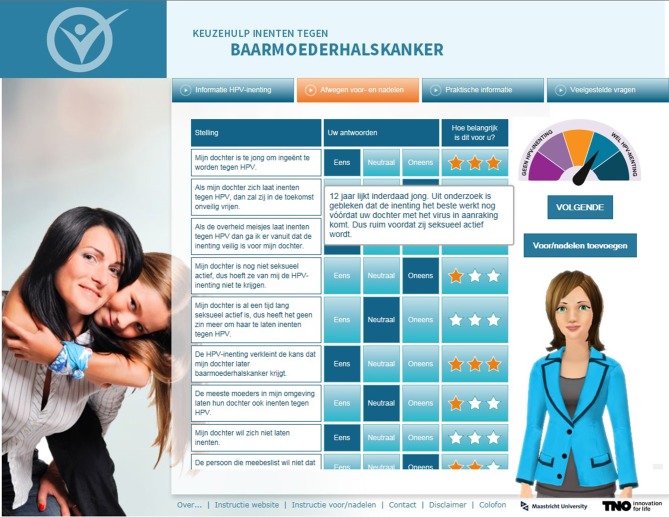
Screenshot of the decisional balance with a tailored pop-up and the mother-like virtual assistant on the website. *The plan for the decisional balance was developed in step 3; actual development of the balance was realized in step 4.